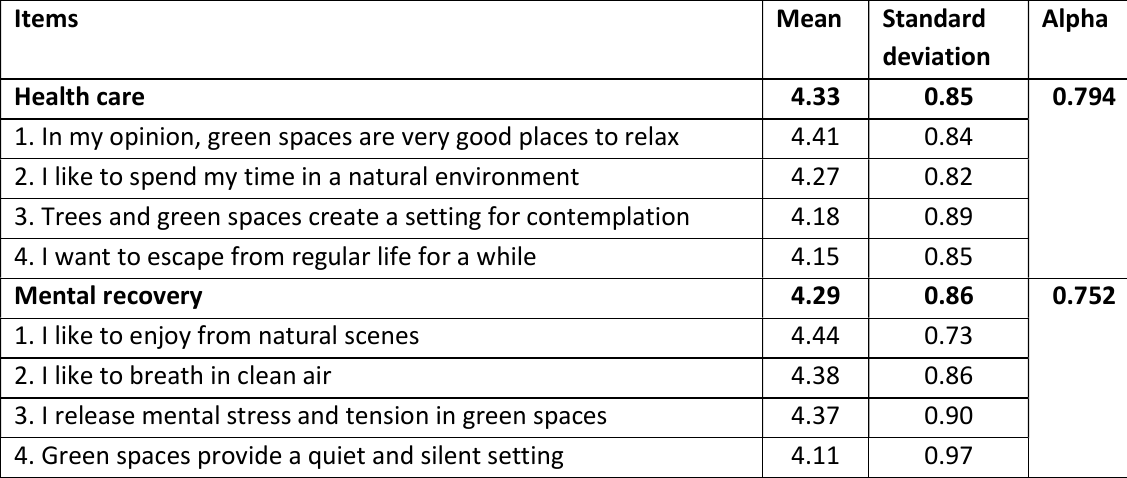
Table 4: Public Preference for Landscape Benefits in the Urban Parks